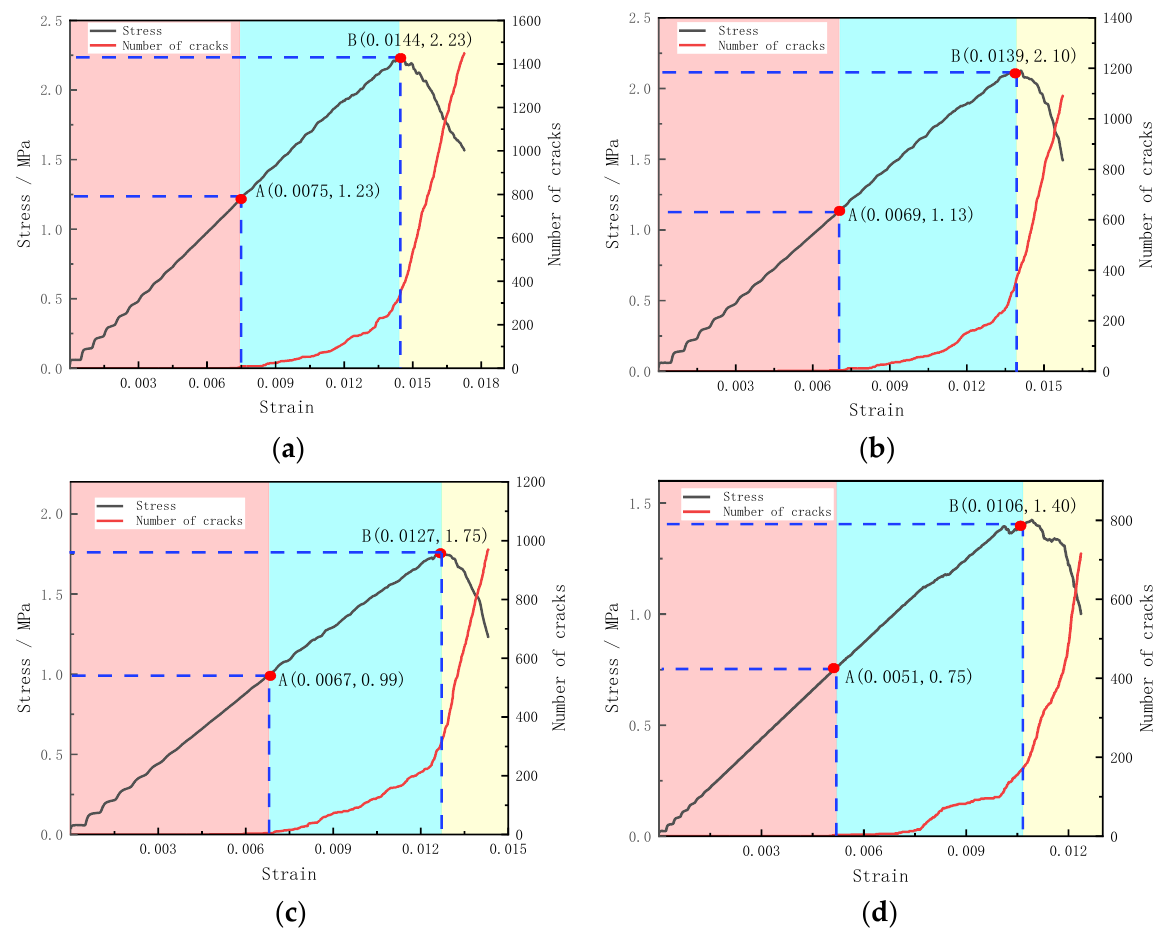
( d ) Figure 7. Failure mode of numerical model of horizontally layered filling body; ( a ) one layer, ( b ) two layers, ( c ) three layers, ( d ) four layers. 3.3.2. Analysis of Fracture Evolution Law of Layered Cemented Filling Body